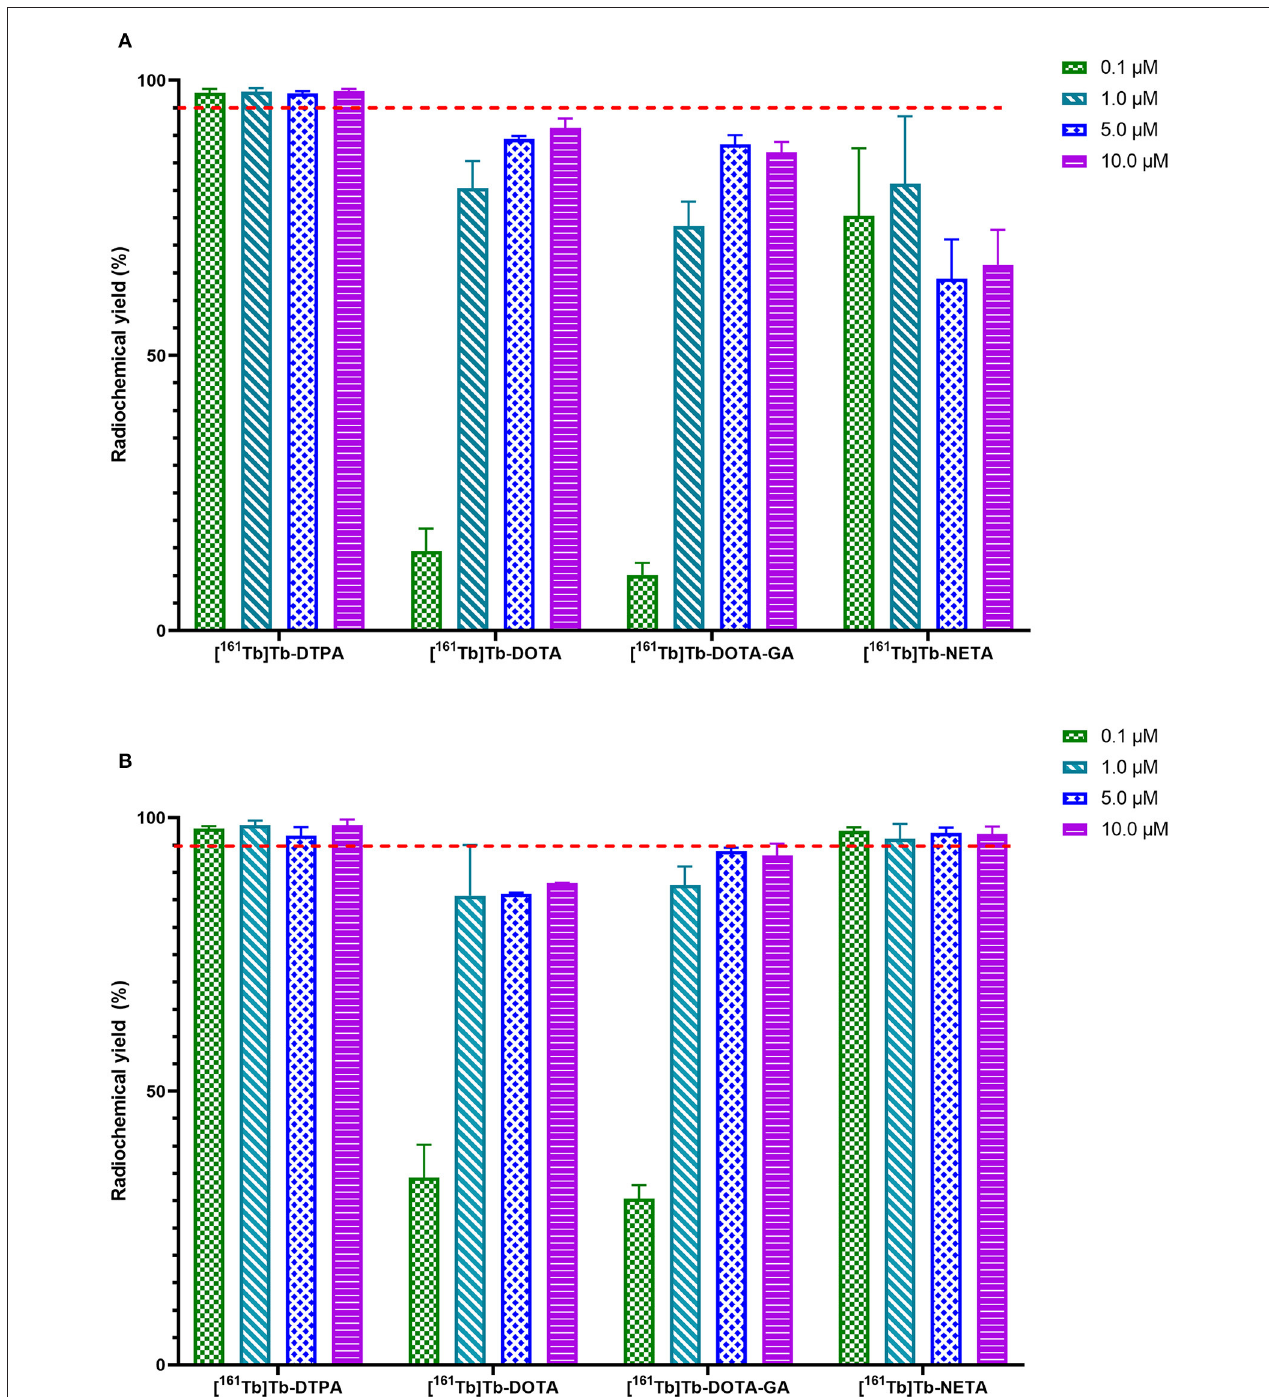
FIGURE 2 | Radiochemical yields of [ 161 Tb]Tb- L (where L = DTPA , DOTA , DOTA-GA or NETA ) at 25 ◦ C (A) and 40 ◦ C (B) after 60min. Red line is inserted to indicate quantitative yield (95%).